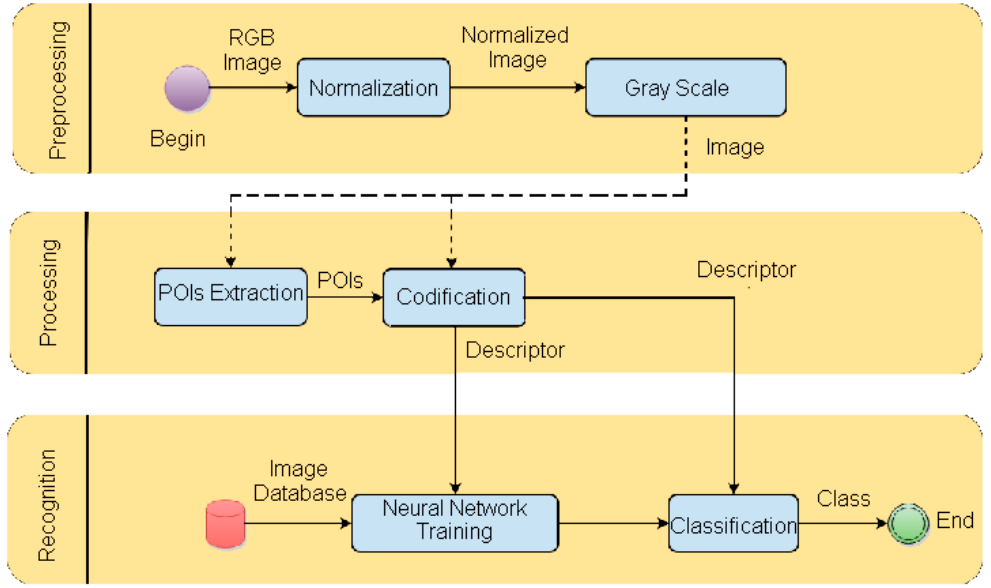
Figure 2. PCNC structure.